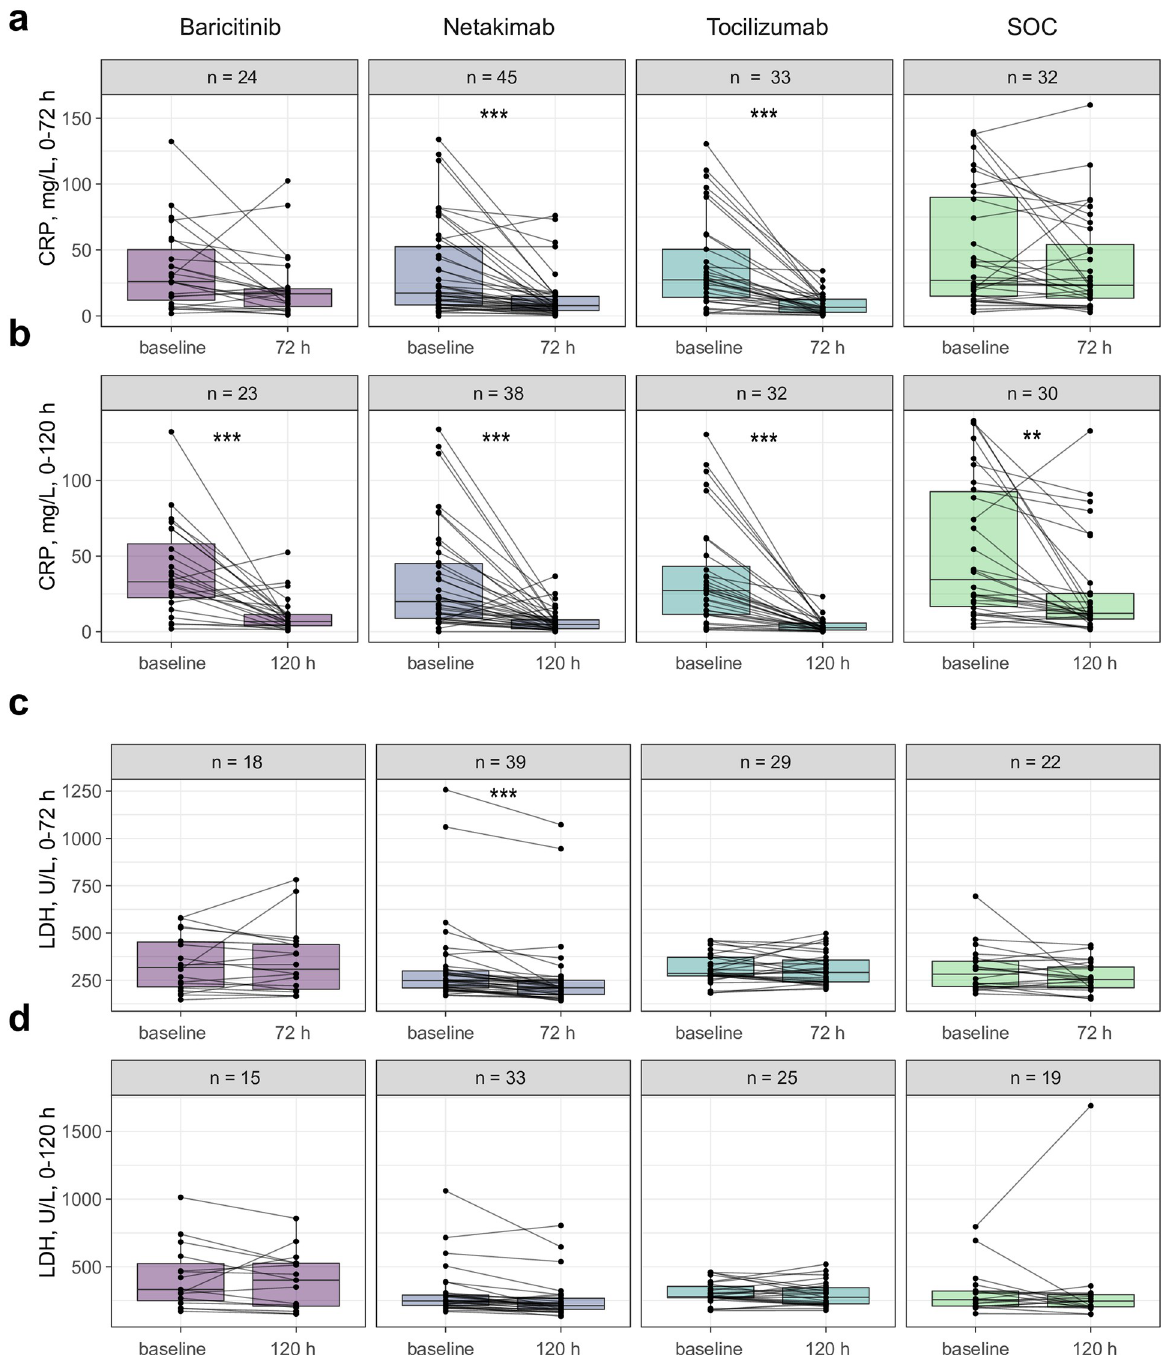
Fig 1. Changes in CRP and LDH levels over time. Measured levels of C-reactive protein (CRP) at baseline versus 72 h ( a ) or 120 h ( b ). Measured levels of lactate dehydrogenase (LDH) at baseline versus 72 h ( c ), or 120 h ( d ). Dots show measurements for individual patients, n = number of patients with available values of the corresponding parameters. Wilcoxon test: �� p < 0.01; ��� p < 0.001.